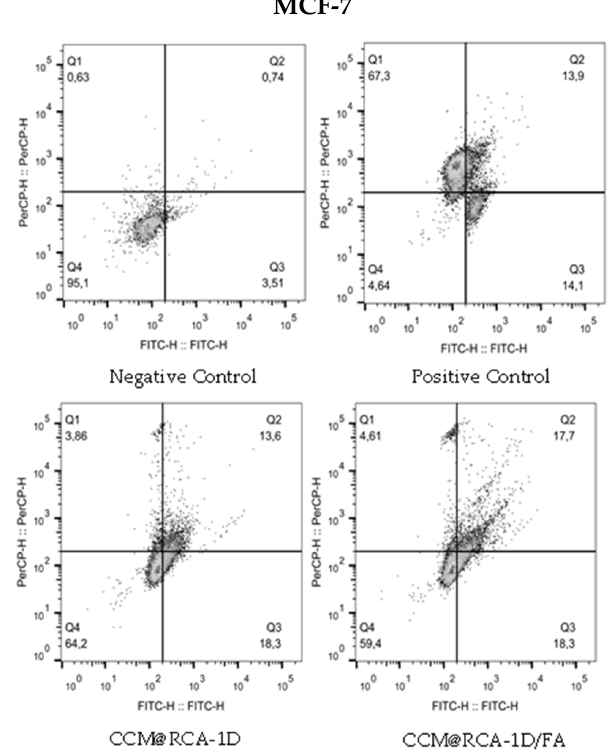
Figure 14. Graph representing IC 50 values of RCA, CCM, compounds CCM@RCA − 1D and